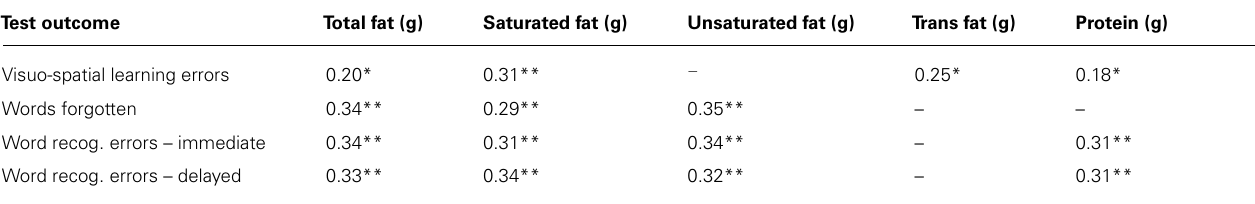
Table 6 |Adjusted R 2 values and significance for the overall multiple regression models examining potential mediation by total energy intake of the macronutrient-cognition association, including age, verbal IQ and activity as covariates. Test